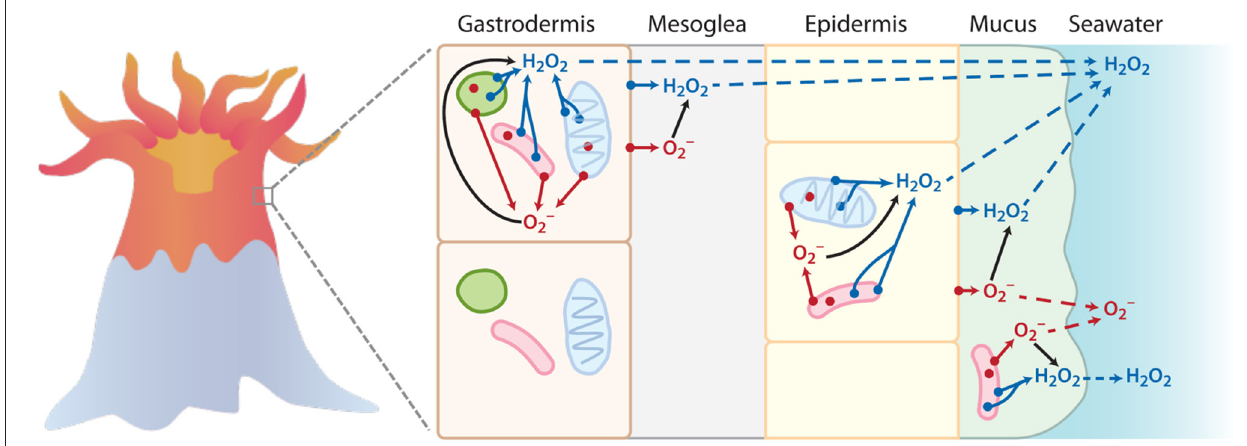
FIGURE 1 | Simplified schematic to illustrate the points of origin (denoted by a dot) for superoxide (O − 2 ) (in red) and hydrogen peroxide (H 2 O 2 ) (in blue) within coral tissue. The outer membranes of host cells, mitochondria (blue oval), Symbiodinium (green circle), and bacteria (pink rod) are represented as potential sites of intracellular and extracellular ROS production (not to scale). While this schematic may not depict all the possible sources of superoxide and hydrogen peroxide production in corals, it is meant to provide a simple conceptual framework. In particular, the superoxide anion only has a limited ability to cross membranes at physiological pH, and thus intracellular formation of superoxide does not significantly impact extracellular pools. In contrast, hydrogen peroxide can travel throughout the coral tissue (transport denoted by dotted lines), and thus intracellular hydrogen peroxide sources can contribute to extracellular pools. Superoxide produced outside of cells via extracellular or transmembrane proteins can interact with surrounding cells. For instance, extracellular superoxide production by Symbiodinium or bacteria could directly interact with coral cells (see top gastrodermal cell). Direct measurements of external superoxide would likely include superoxide formed at the plasma membrane of coral epithelial cells as well as extracellular superoxide generated by bacteria in the mucus